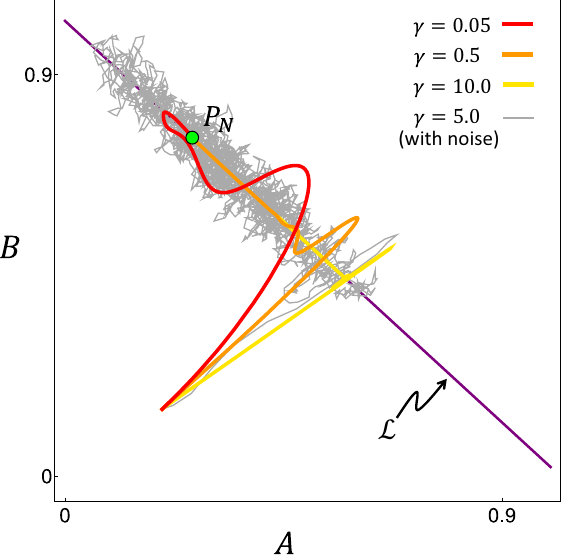
Figure 5. Trajectories of the system projected in the A - B plane, with parameters inside the coexistence region (by holding the position of P N fixed). As γ increases, the system tends to approach the line L quickly and then crawl along it. The grey trajectory is with independent Gaussian white noise ( ∼ N ( 0, 0.5 ) ) added to each variable’s dynamics. Noise causes the system to diffuse along L for a long transient period before coming to the equilibrium point P N . Parameters used here are ( a 0 , a 1 , a 2 , b 0 , b 1 , b 2 ) = ( 0.2, 0.8, 0.5, 0.2, 0.6, 0.9 ) , chosen to place P N away from the middle of L to show the trajectory drifting toward the